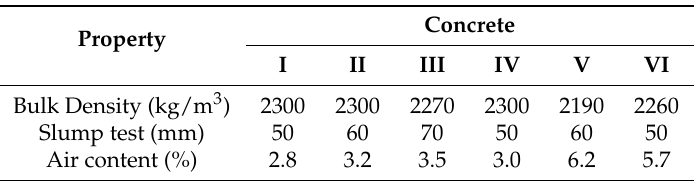
Table 8. Composition of the